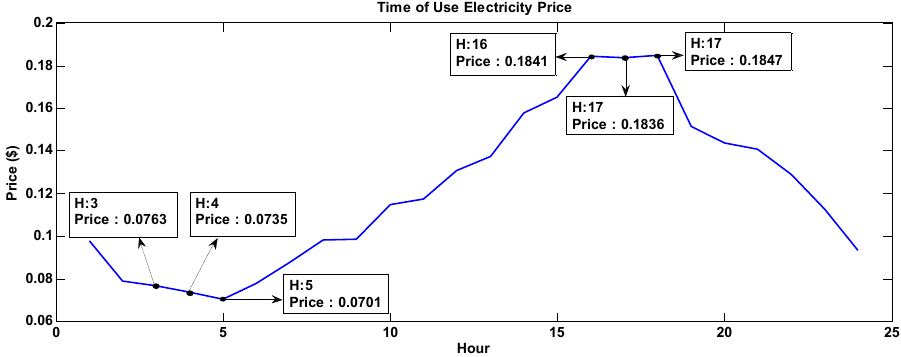
Figure 16. Electricity pricing signals during the use of the home energy management (HEM) system.